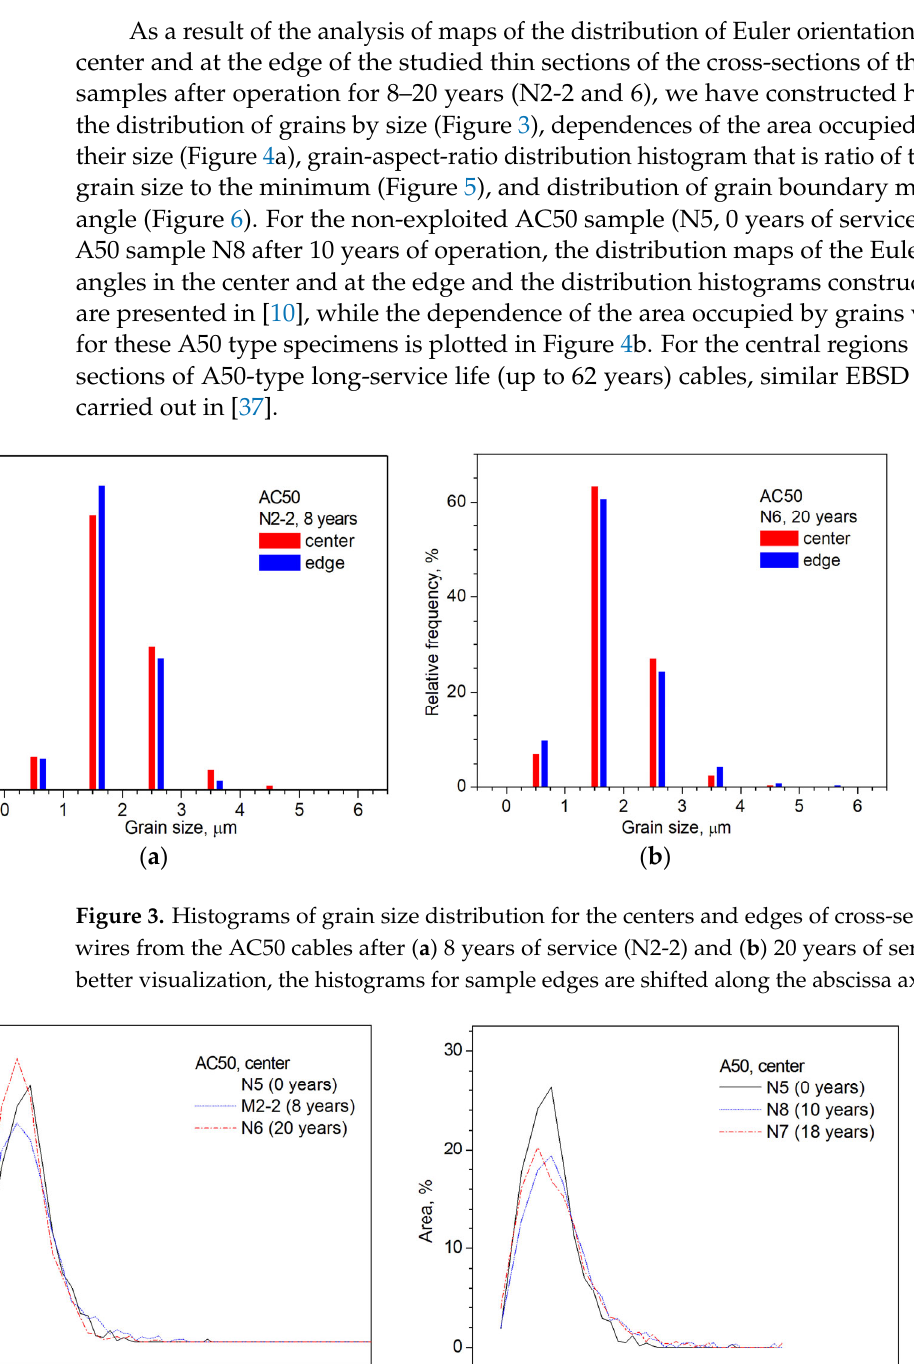
Figure 2. Distribution maps of Euler angles at the center ( a , b ) and at the edge ( b , c ) for cross ‐ sections of AC50 samples after ( a , c ) 8 (sample N2 ‐ 2) and ( b , d ) 20 (N6) years of service life. The legend for maps ( a – d ) is shown in ( e ). Scale for the Euler angle Φ is the same as for φ 2 .